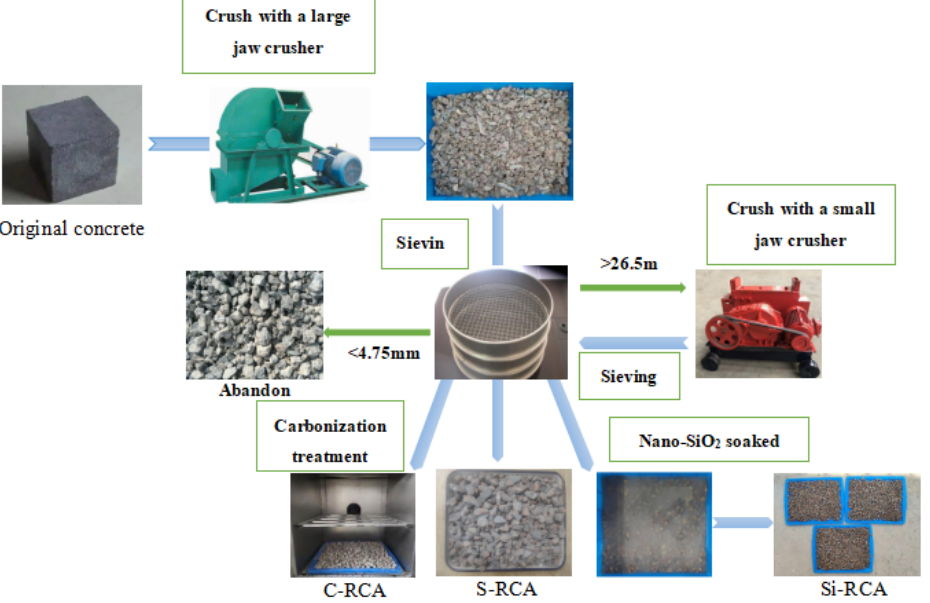
Figure 3. Preparation process of recycled coarse aggregates (RCA): S-RCA–simple crushed of original concrete, C-RCA–simple crushed and carbonization treatment, Si-RCA–simple crushed and nano-SiO 2 solution soaking.